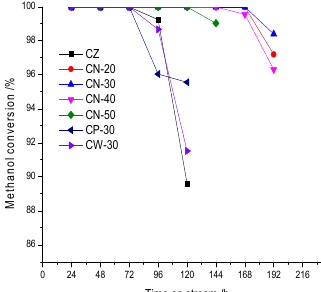
Figure 12. The change in methanol conversion with time on stream. The hydrocarbon product distribution of MTH over the catalysts with time on stream is shown in Figure 13. In the range of the active period (methanol conversion is 100%) the selectivity of light olefin (C 2= , C 3= and C 4= alkenes) increases, low ‐ carbon al ‐ kanes (C 2 °, C 3 ° and C 4 ° alkanes), except methane, decrease and the selectivity of C 5+ de ‐ creases gradually with time on stream.